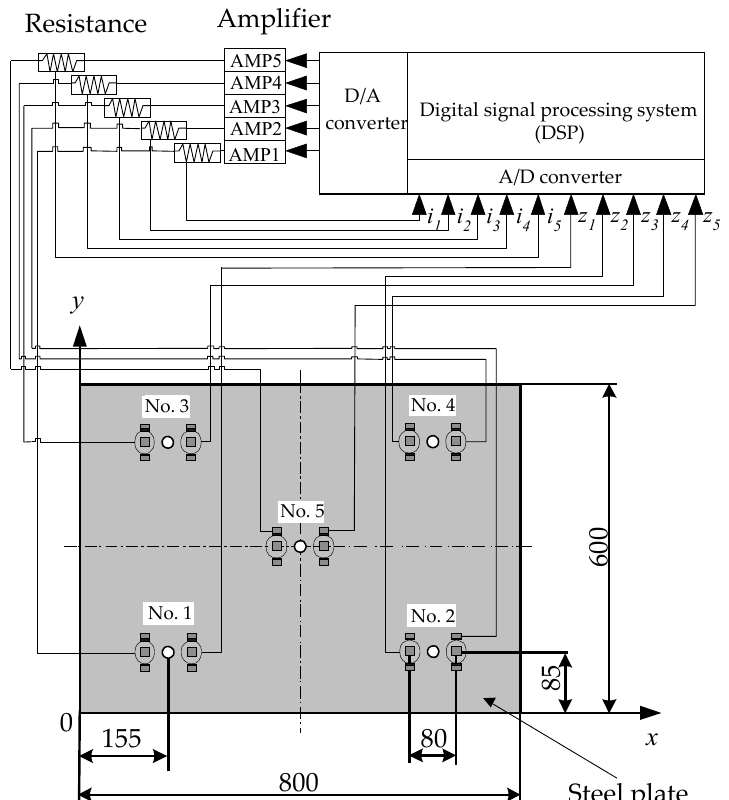
Figure 1. Electromagnetic levitation control system.